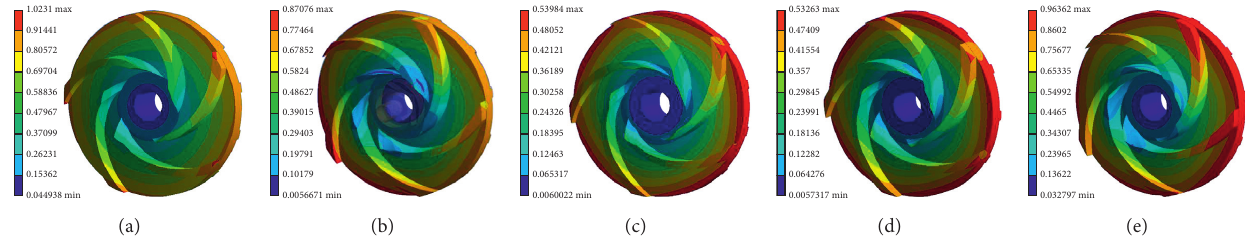
Figure 21: Impeller deformation with different wrap angles. (a) φ � 100 ° . (b) φ � 110 ° . (c) φ � 120 ° . (d) φ � 140 ° . (e) φ � 150 ° .